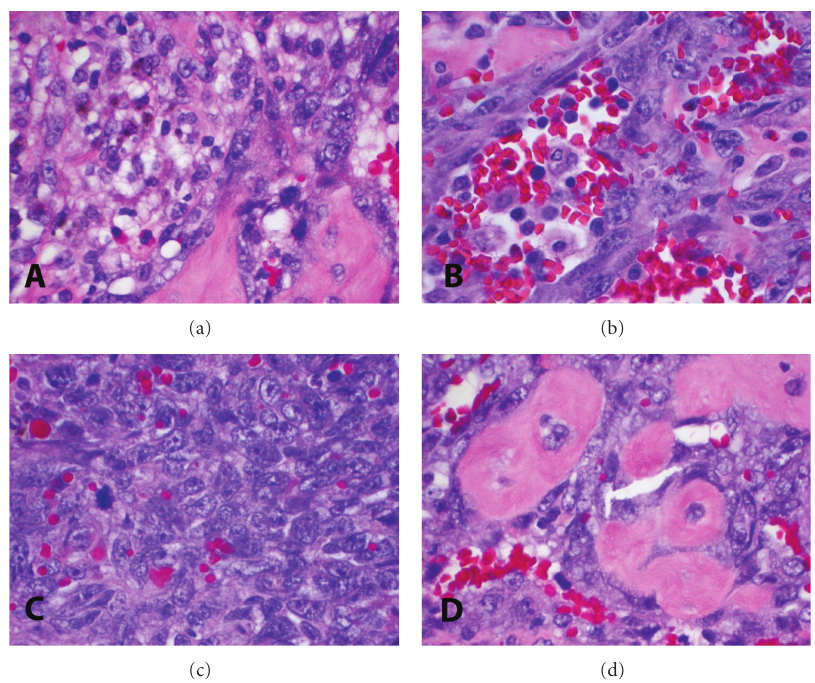
Figure 4: (a) Hemosiderin deposition in tumor; (b) anastomosing vascular channels; (c) frequent atypical mitotic figures and intra- cytoplasmic “vascular channels;” (d) dense collagen deposition in basement membrane type